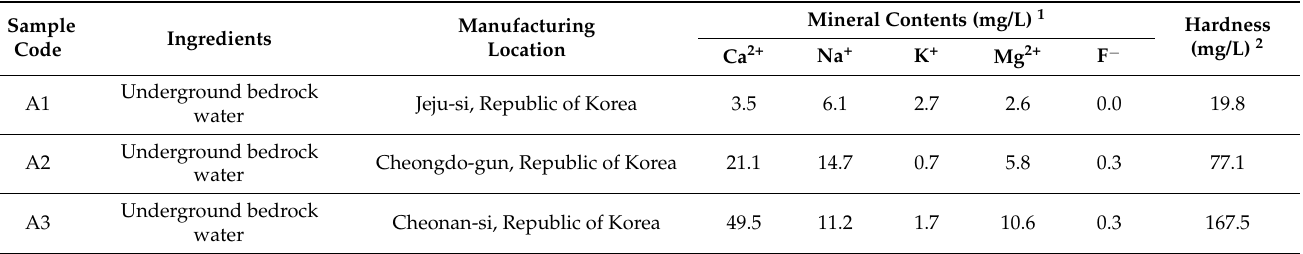
Table 1. The water samples information and mineral